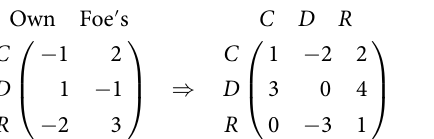
6.3270; p value < 10 − 9 ) than the median frequency of defection equal to